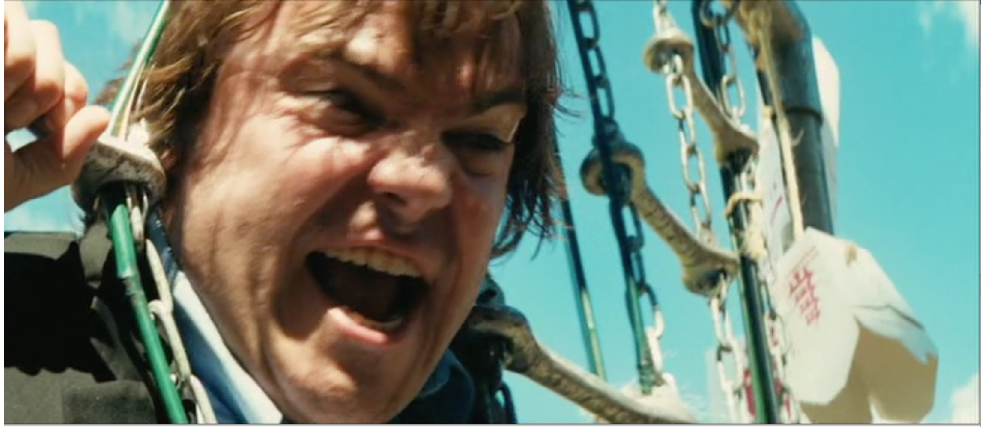
Figure 6. Jack Black plays Jackie Chan in the sweded Rush Hour 2 (Brett Ratner 2001). Jack Black plays Jackie Chan in the sweded Rush Hour 2 . The “#OscarsSoWhite” boycott of 2016 and